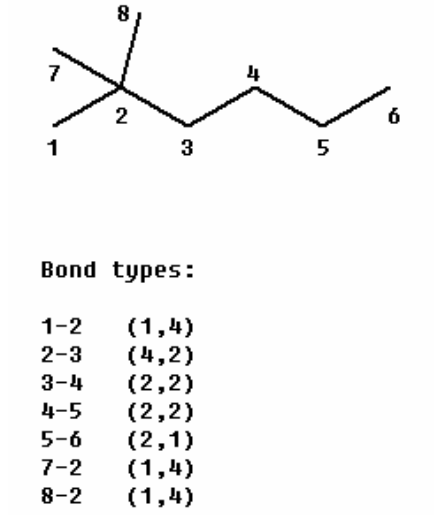
Figure 1. The partitioning of the connectivity index of 2, 2-dimethylhexane into bond